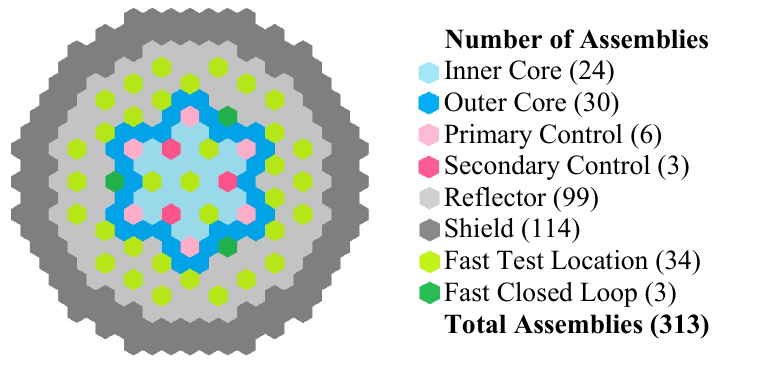
Figure 1. FASTER-like SFR Core